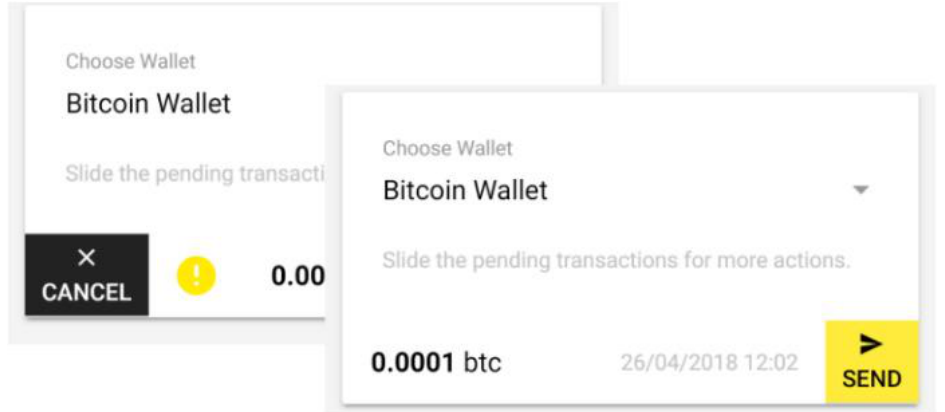
Figure 12. Demonstration of two possible functionalities to perform in a pending transaction.